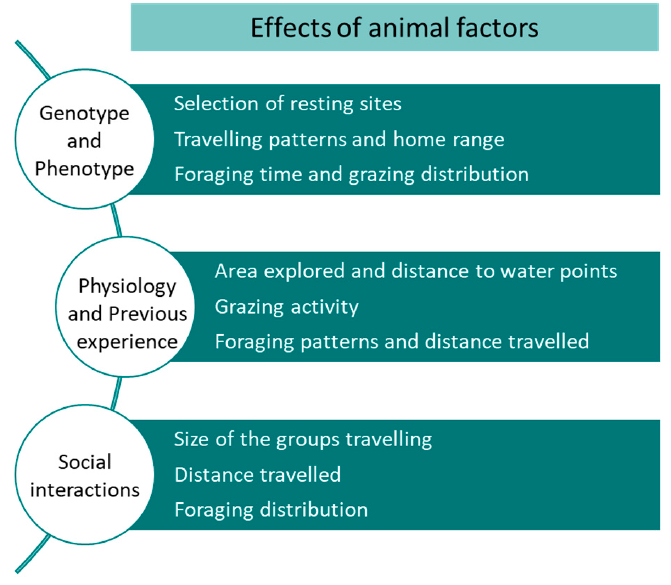
Figure 13. Main effects of animal factors on site use preference by cattle.